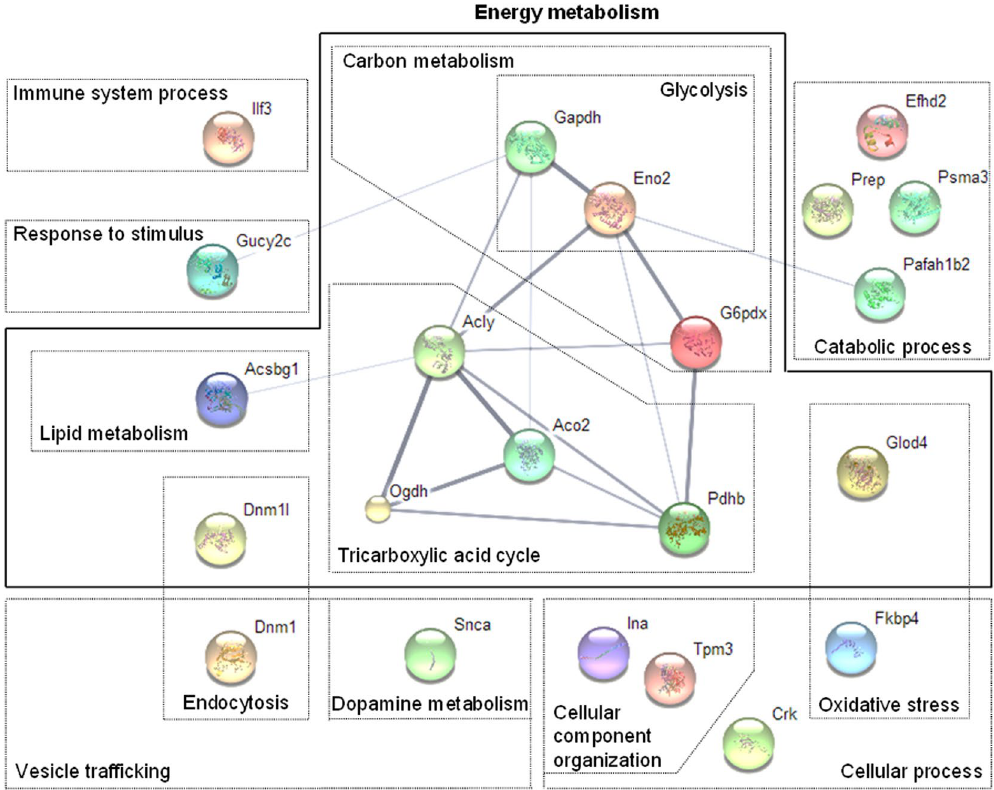
Figure 5. Non-exhaustive representation of proteins clustering analysis. The 22 proteins were analyzed using open source databases UniProt, PANTHER, KEGG and network program STRING, resulting in protein clusters. Proteins were classified according to their biological process including fourteen clusters (cellular component organization, cellular process, oxidative stress, dopamine metabolism, endocytosis, vesicle trafficking, lipid metabolism, tricarboxylic acid cycle, catabolic process, glycolysis, carbon metabolism, response to stimulus, immune system process and energy